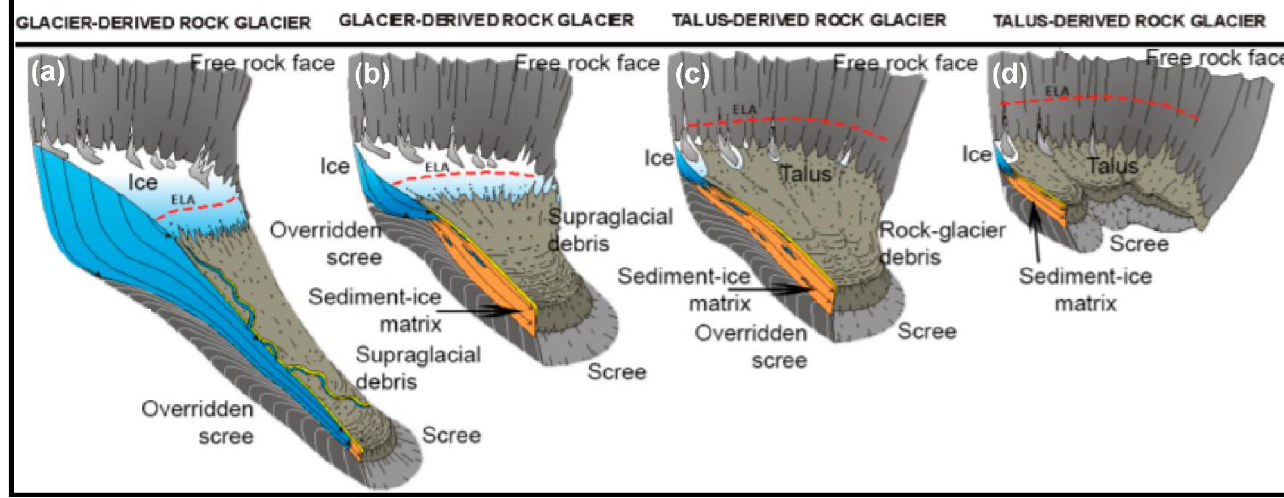
Figure 4. Glacier-derived rock glacier to talus-derived rock glacier examples. Images with higher elevation equilibrium lines (decreasing ice accumulation) towards the right. ( a ) Glacier-derived rock glacier, ELA present on glacial body; ( b ) glacier-derived rock glacier, ELA migrated up closer to rock face; ( c ) talus-derived rock glacier, ELA now above glacier body; ( d ) talus-derived rock glacier, ELA migrating further above glacier body. Figure adapted from Humlum et al. [81].